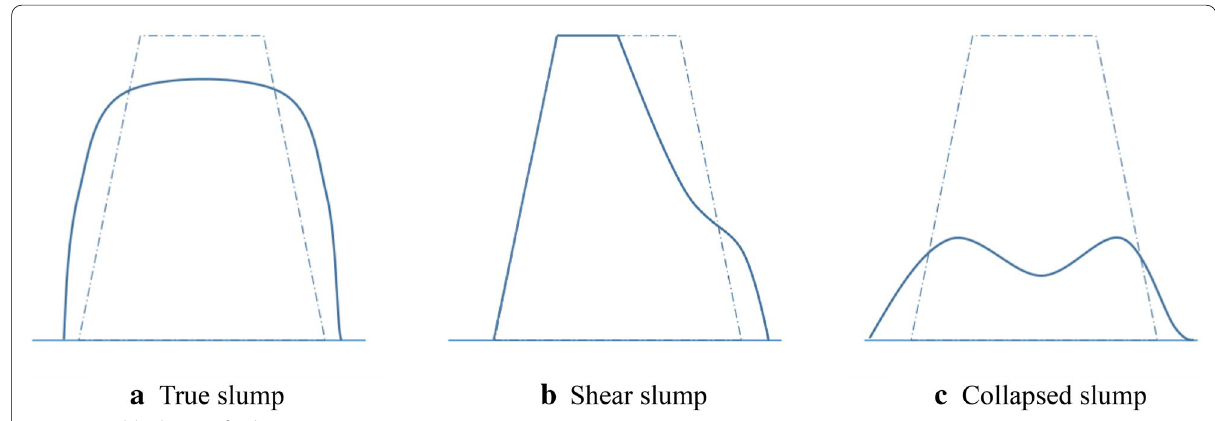
Fig. 1 Possible shapes of a